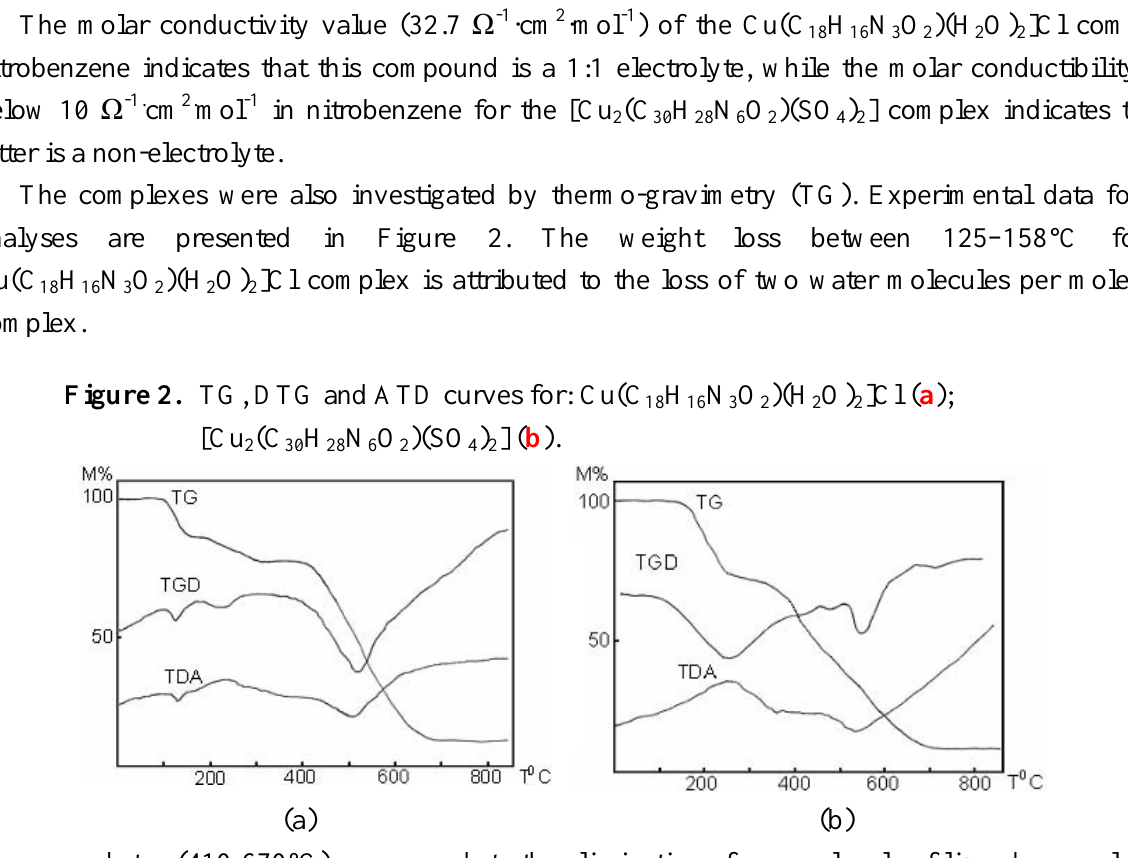
H N O )(H O) ]Cl ( a 18 16 3 2 2 2